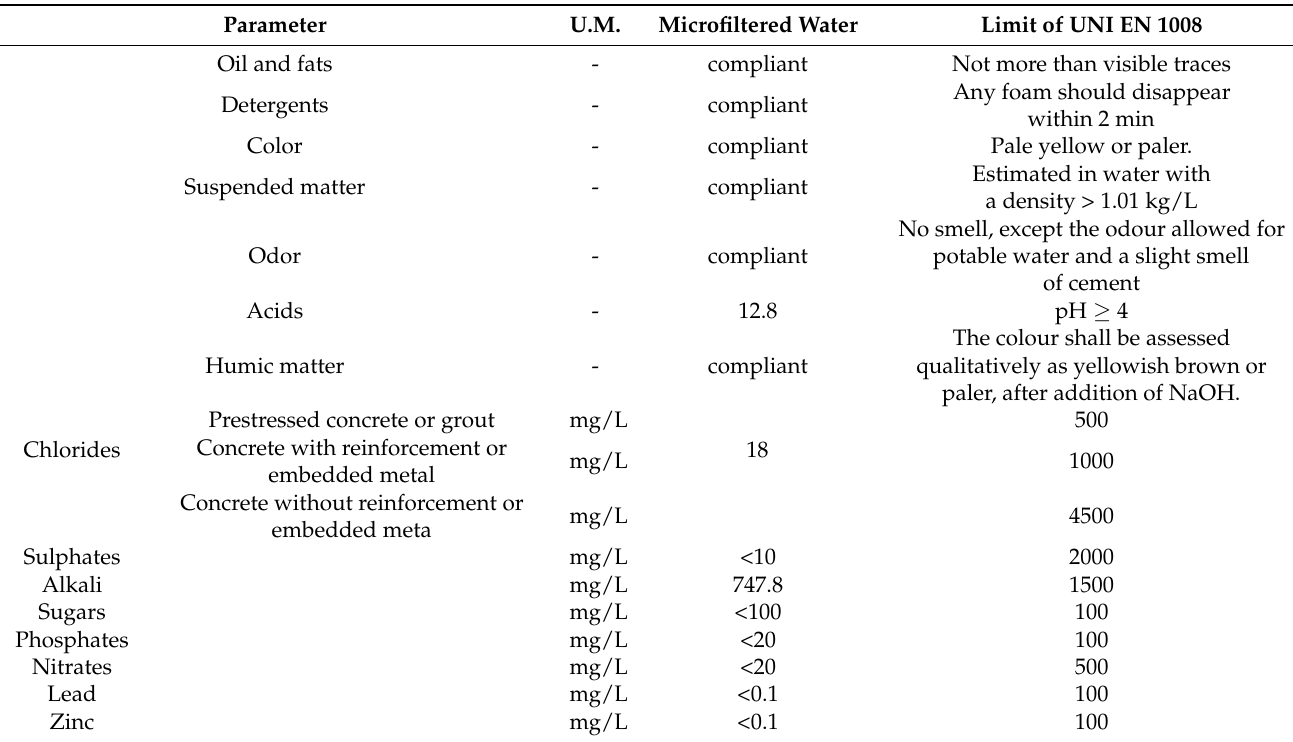
Table 5. Results of the preliminary inspection of mixing water.